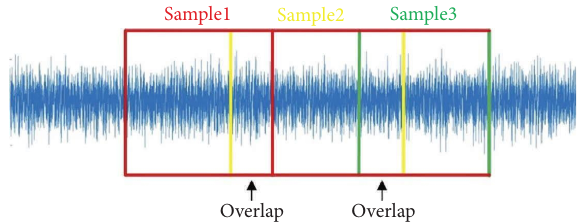
Figure 7: Te schematic diagram of overlapping